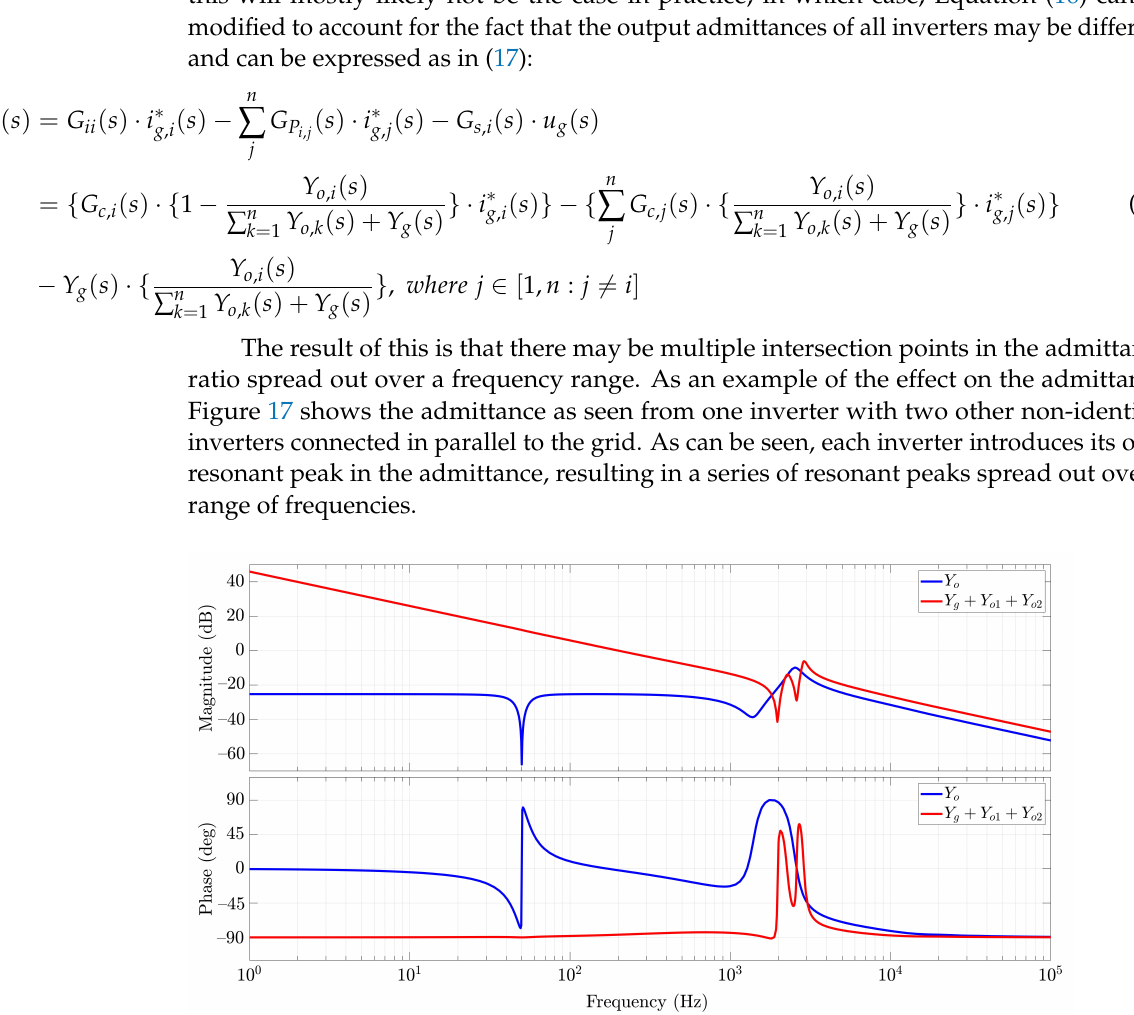
Figure 17. Bode plot of admittances of three different parallel VSIs connected to the